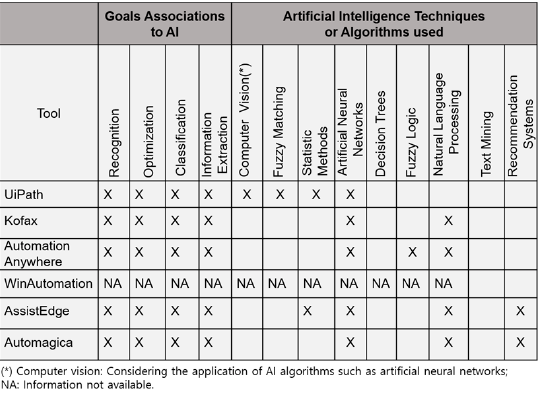
Figure 2. Comparison of RPA solution functions. Adaptation based on Ref. [2].